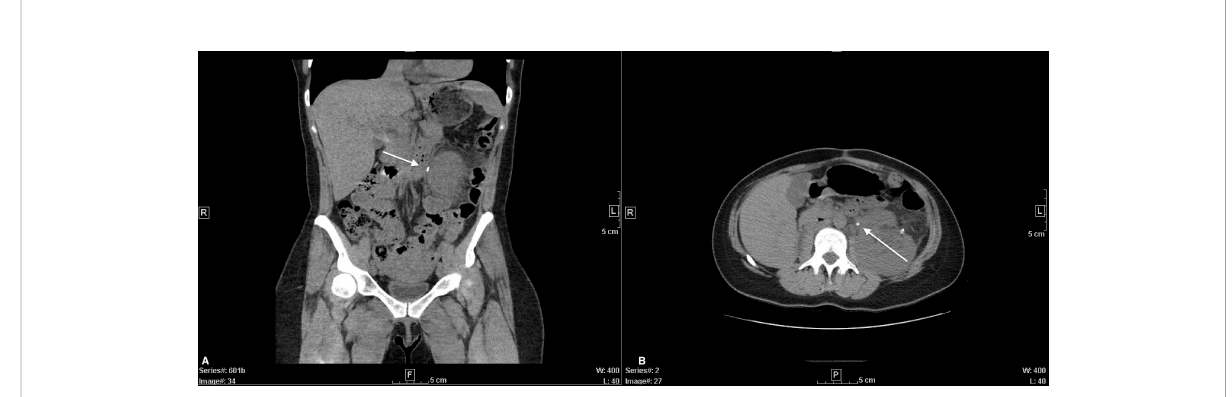
FIGURE 3 CT-Abdomen without contrast. Coronal (A) and axial (B) views displaying left-sided obstructing UPJ